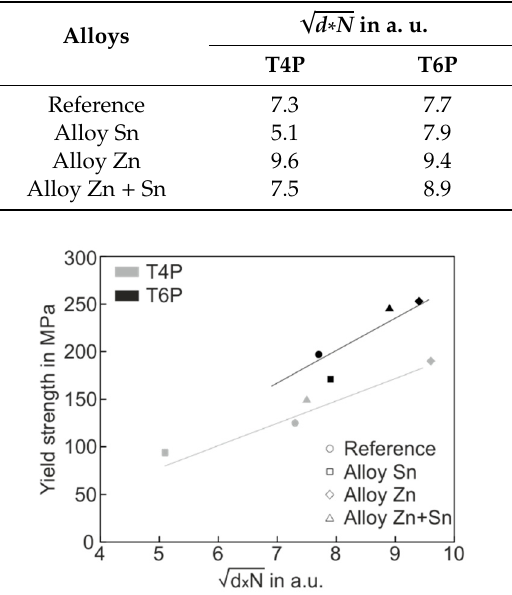
Figure 8. Yield strength versus √ 𝑑 ∗ 𝑁 of all experimental alloys in the T4P (grey) und T6P (black) conditions.